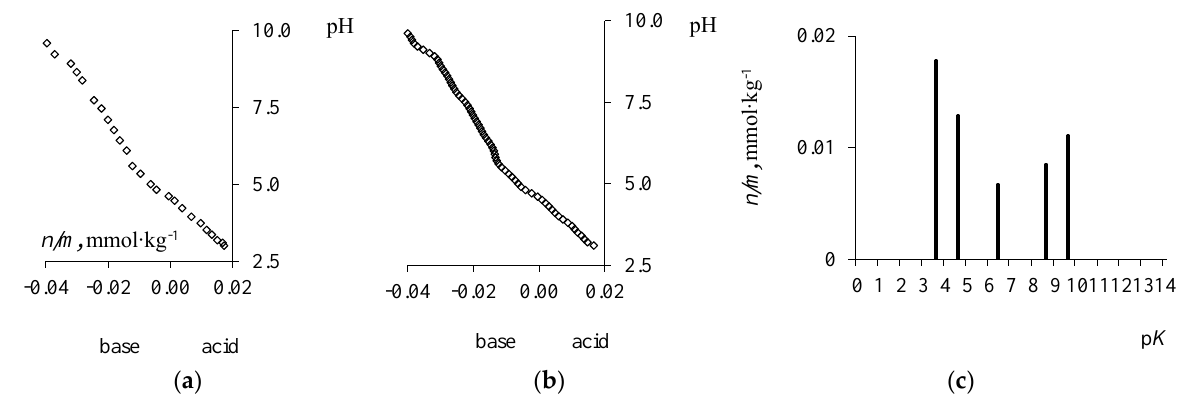
Figure 1. Example of the experimental ( a ) and smoothed ( b ) titration curves and the p K spectra ( c ). Negative values of n / m are associated with the introduction of “–“ in the calculation formula .